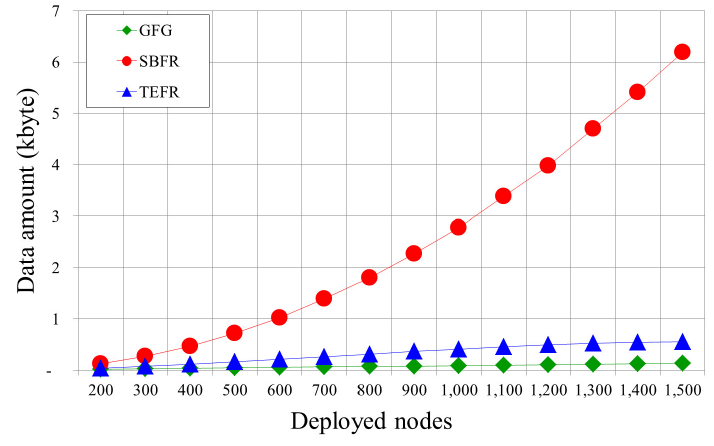
Figure 14. Hop counts according to radio range (deployed nodes: 500).